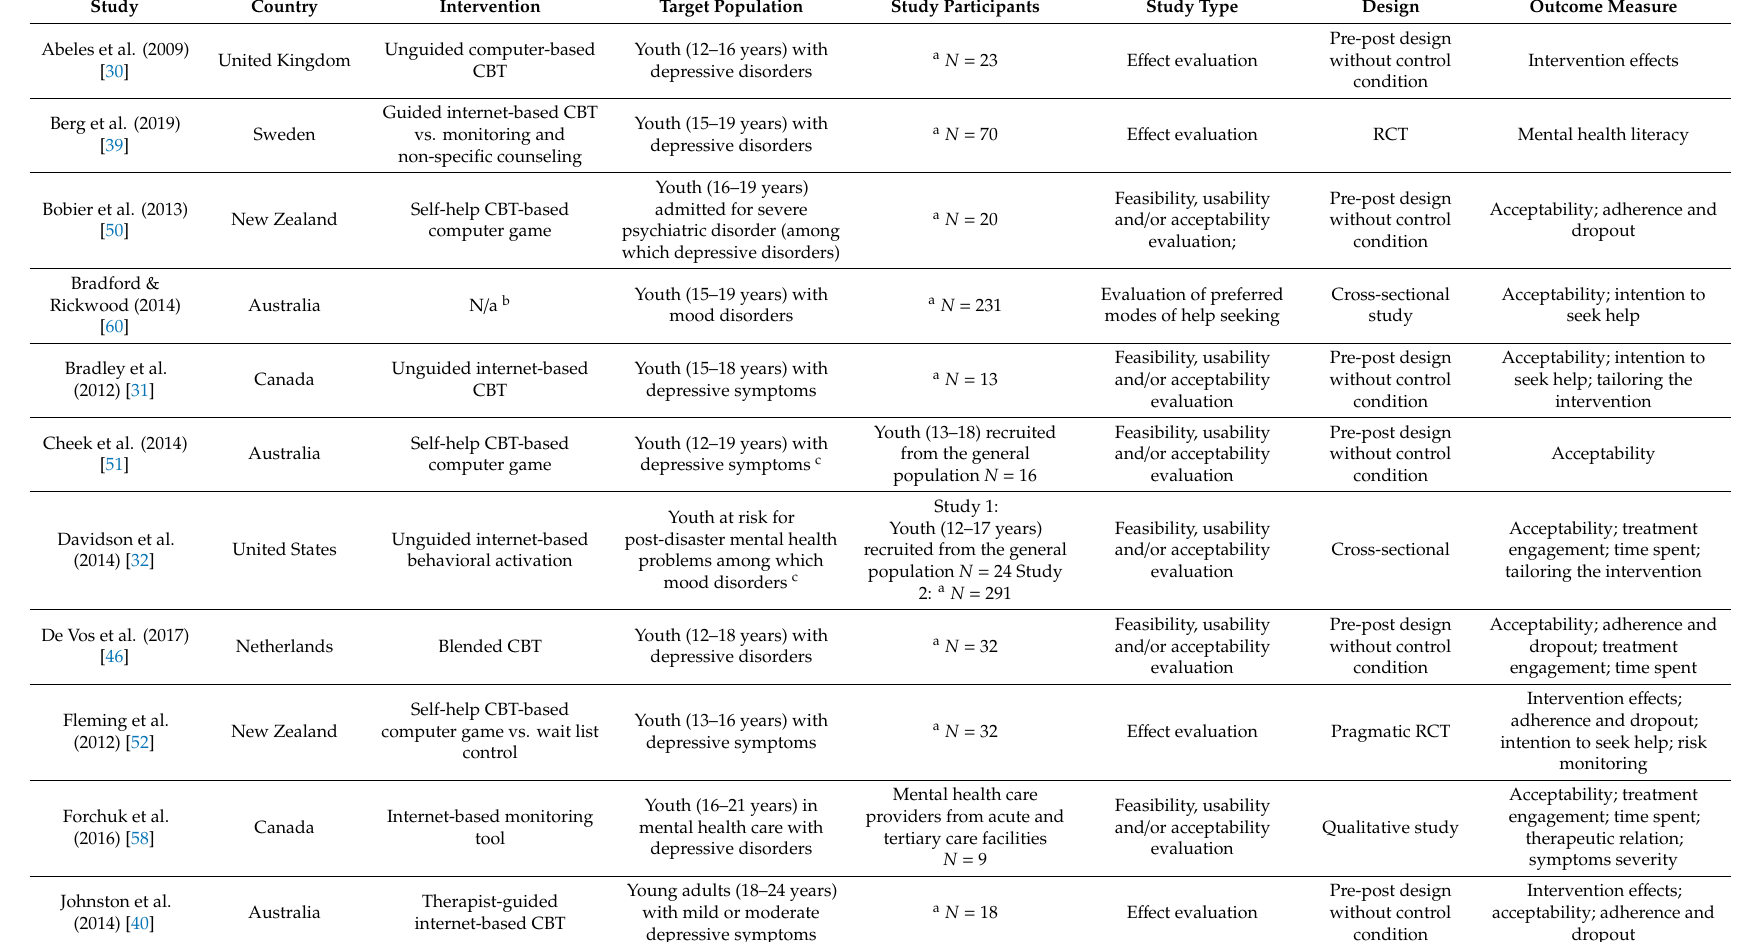
Table 1. Characteristics of the included